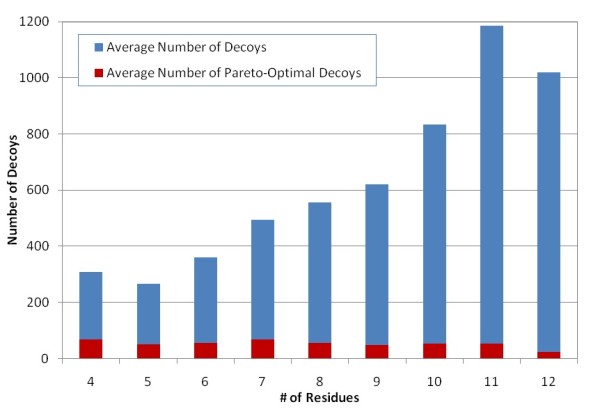
Average number of decoys and average number of Pareto-optimal decoys for loop targets ranging from 4- to 12-residue in Jacobson's decoy sets. Only a small fraction (3~22%) of the decoys of a loop target are Pareto-optimal decoys.